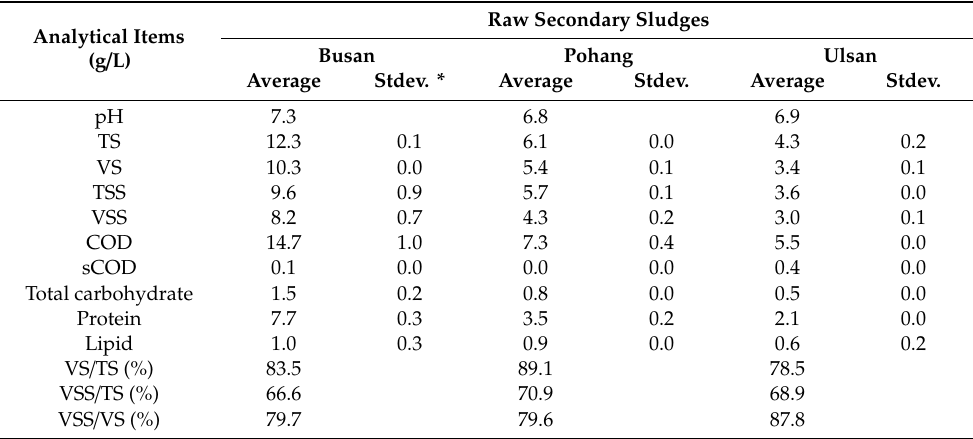
Table 4. Characteristics of the secondary sludge taken from wastewater treatment plants in the cities of Busan, Pohang, and Ulsan. Analytical Items (g /